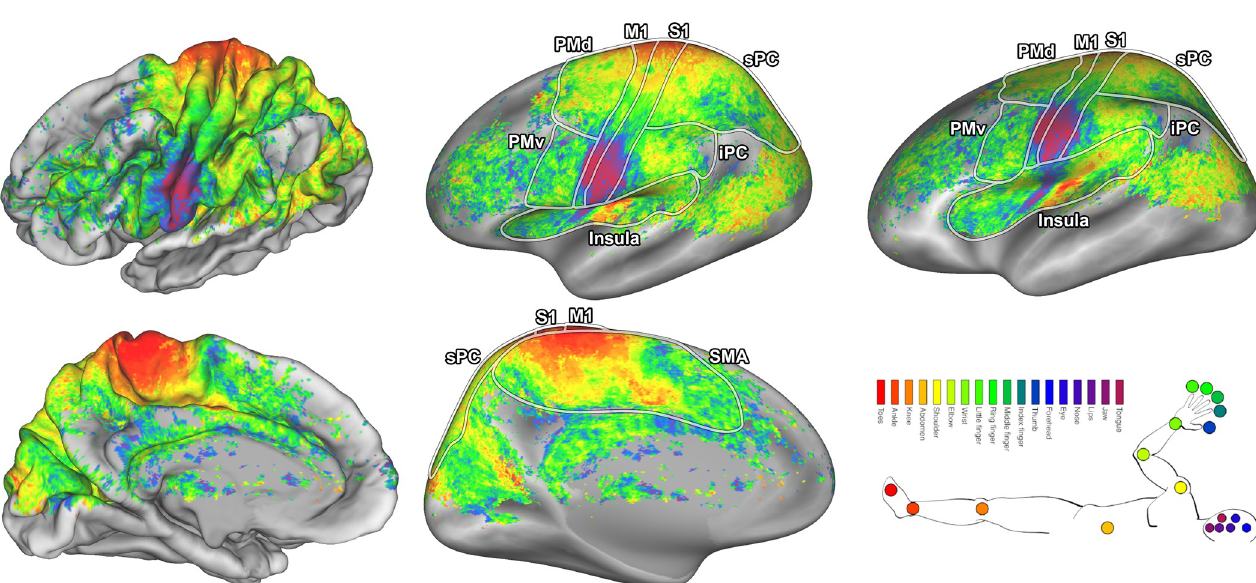
PLOS Computational Biology | https://doi.org/10.1371/journal.pcbi.1009955 April 4,